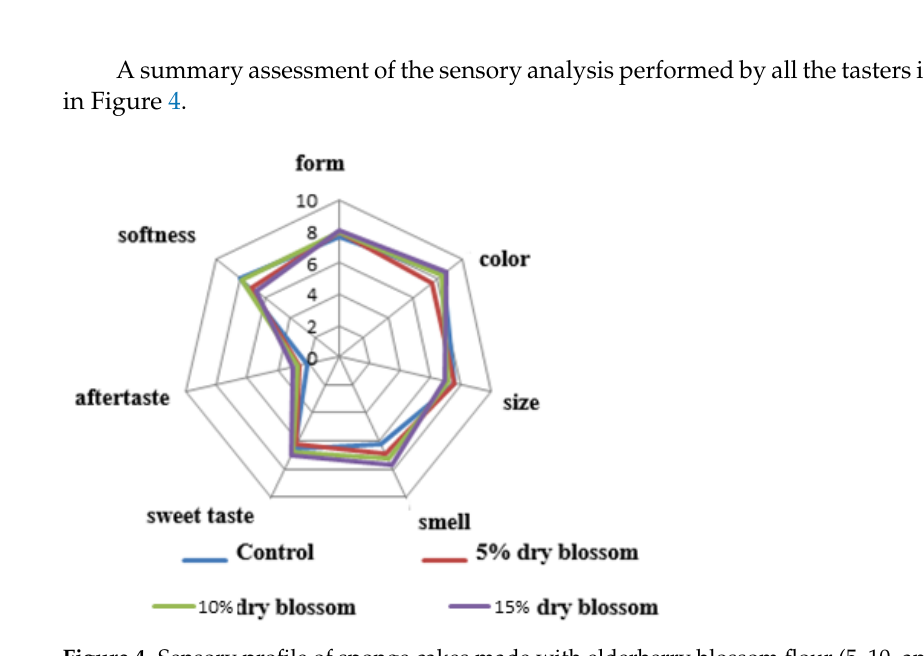
Table 3. Textural properties of Control and Options 1, 2, and 3 sponge cakes.